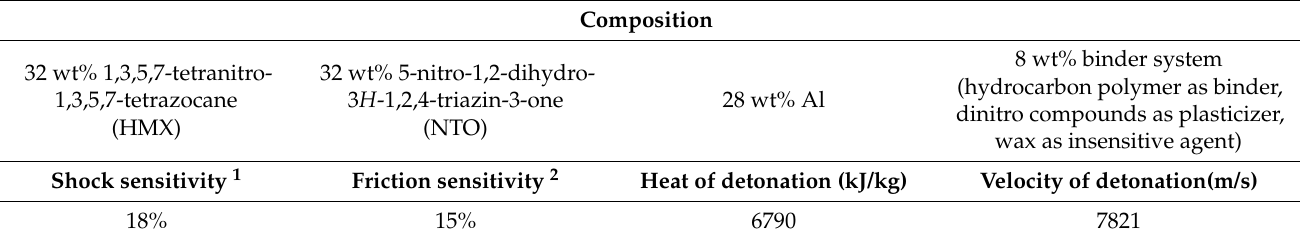
Table 1. Composition/mechanical sensitivity/detonation parameters of JEOL.